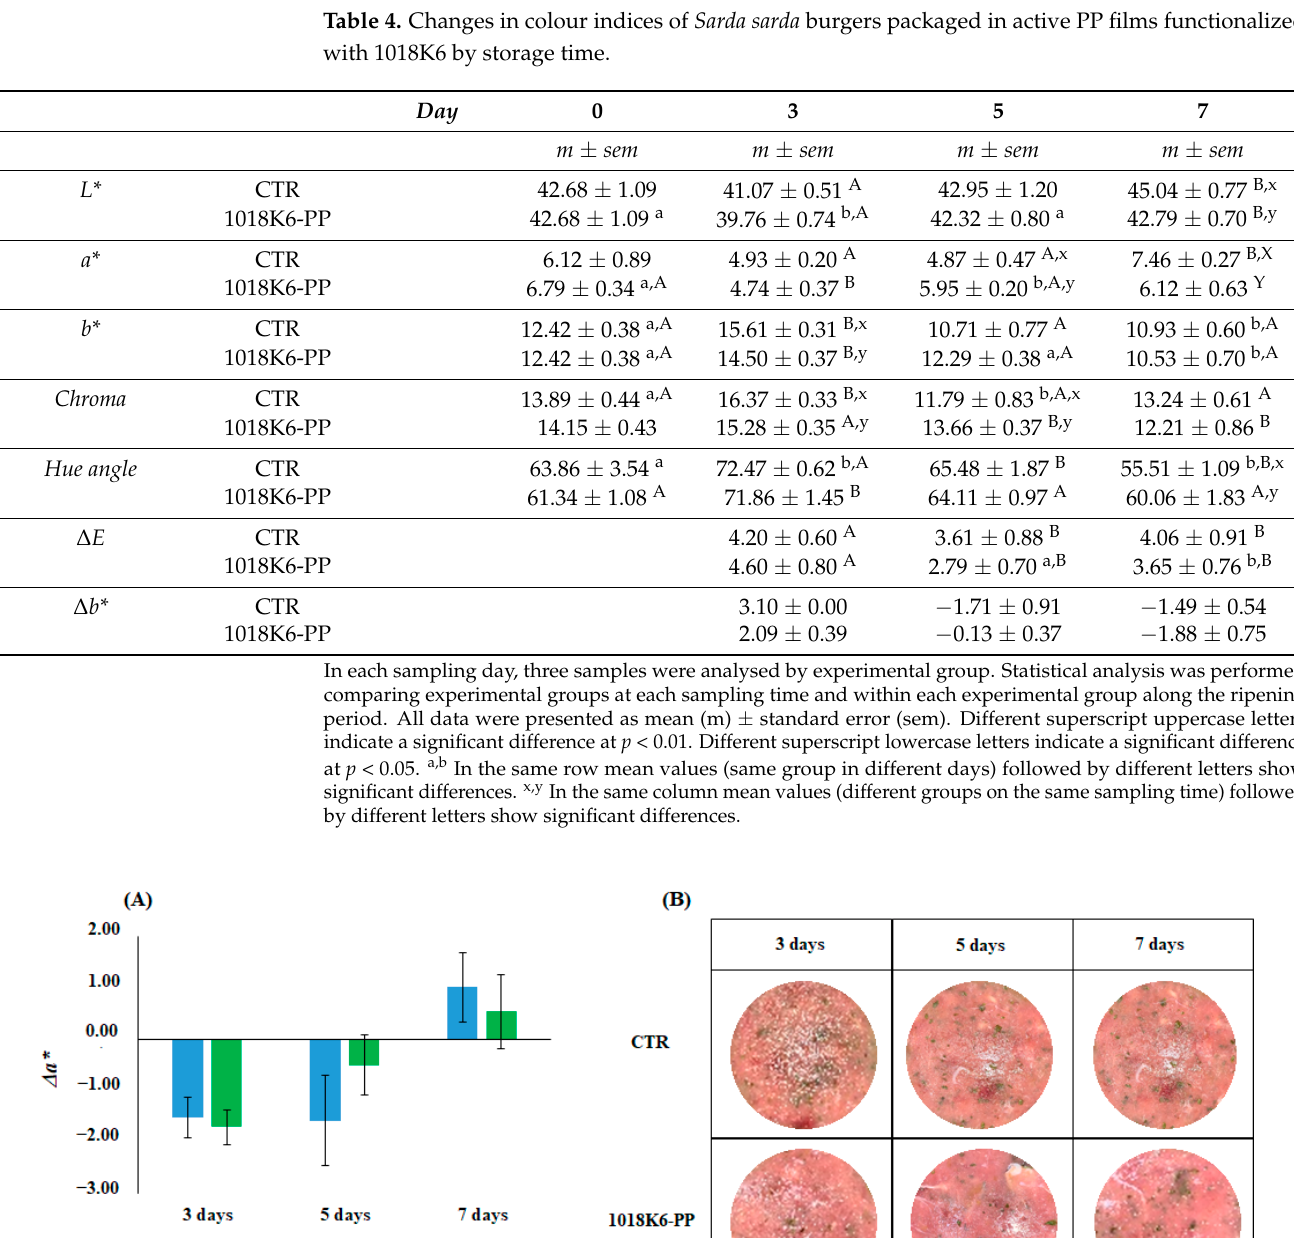
Table 4. Changes in colour indices of Sarda sarda burgers packaged in active PP films functionalized with 1018K6 by storage time.